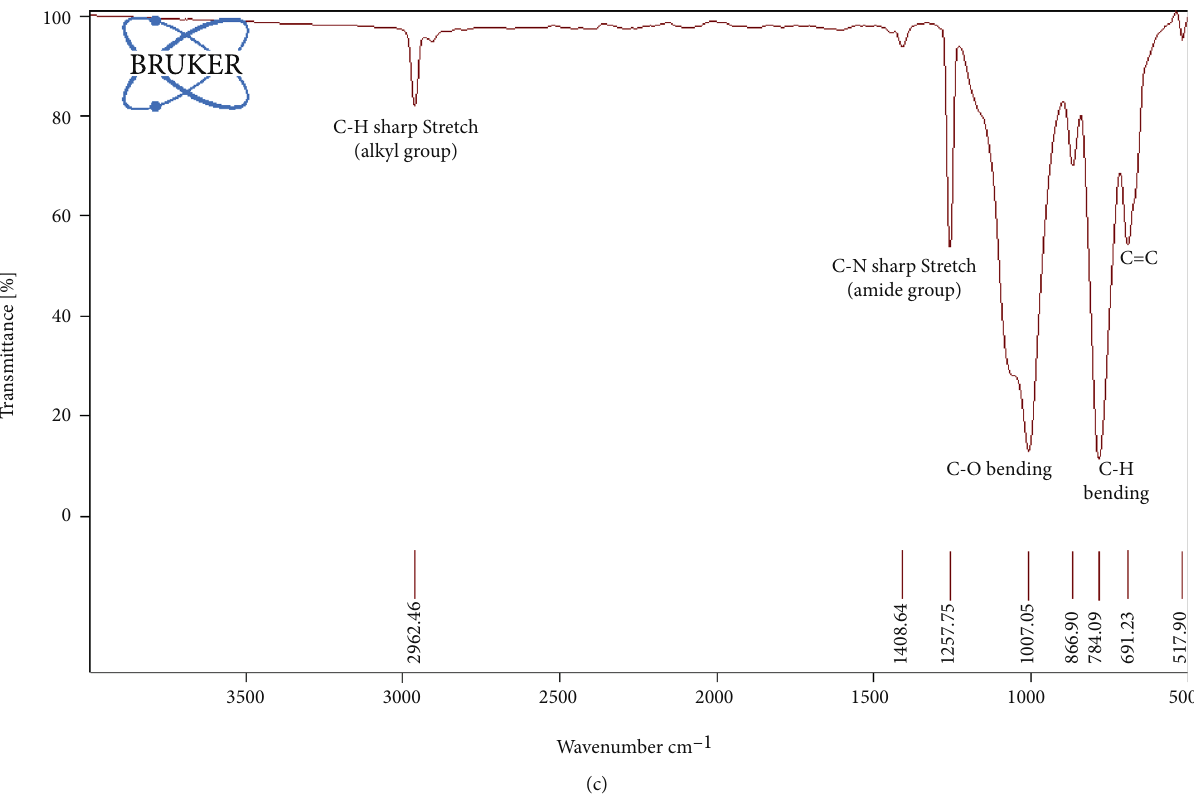
Figure 7: FTIR analysis of basalt fi ber – reinforced anamide resin composites (a) 0 ° fi ber orientation, (b) 30 ° fi ber orientation, and (c) 45 ° fi ber